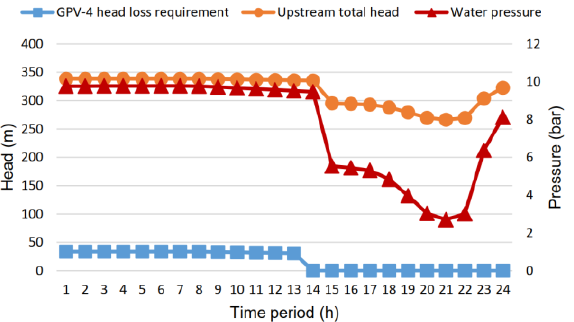
Figure 13. Upstream total head and water pressure before the GPV-4 installation and GPV-4 head loss requirement.